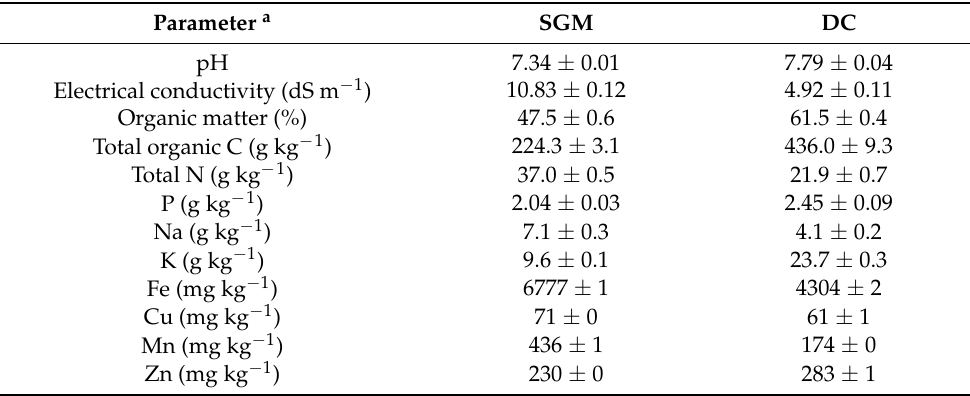
Table 1. Physico-chemical properties and chemical composition of the organic materials used in the experiment.